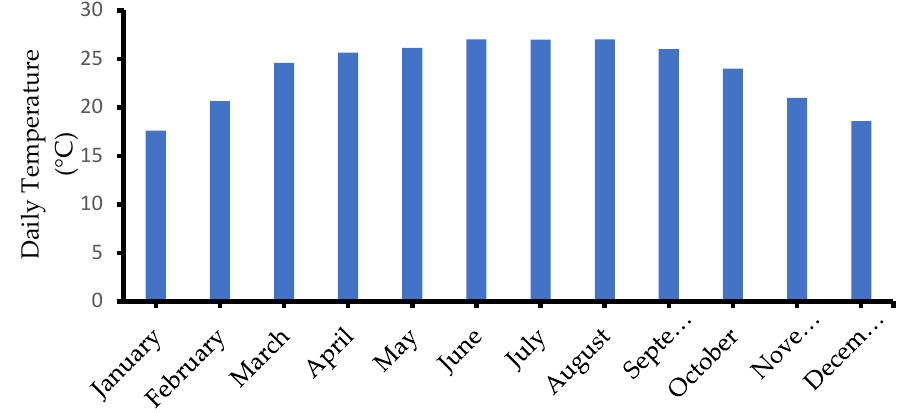
Figure 5. Monthly average temperature